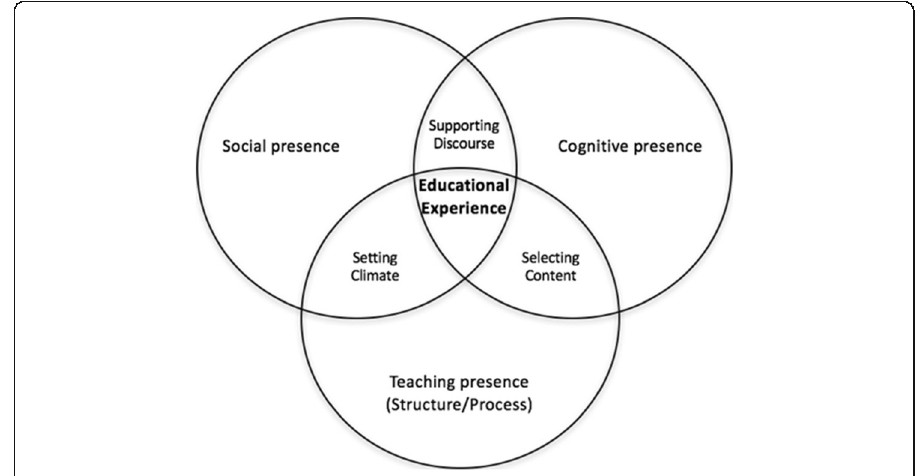
Fig. 3 Community of Inquiry framework (Garrison et al.